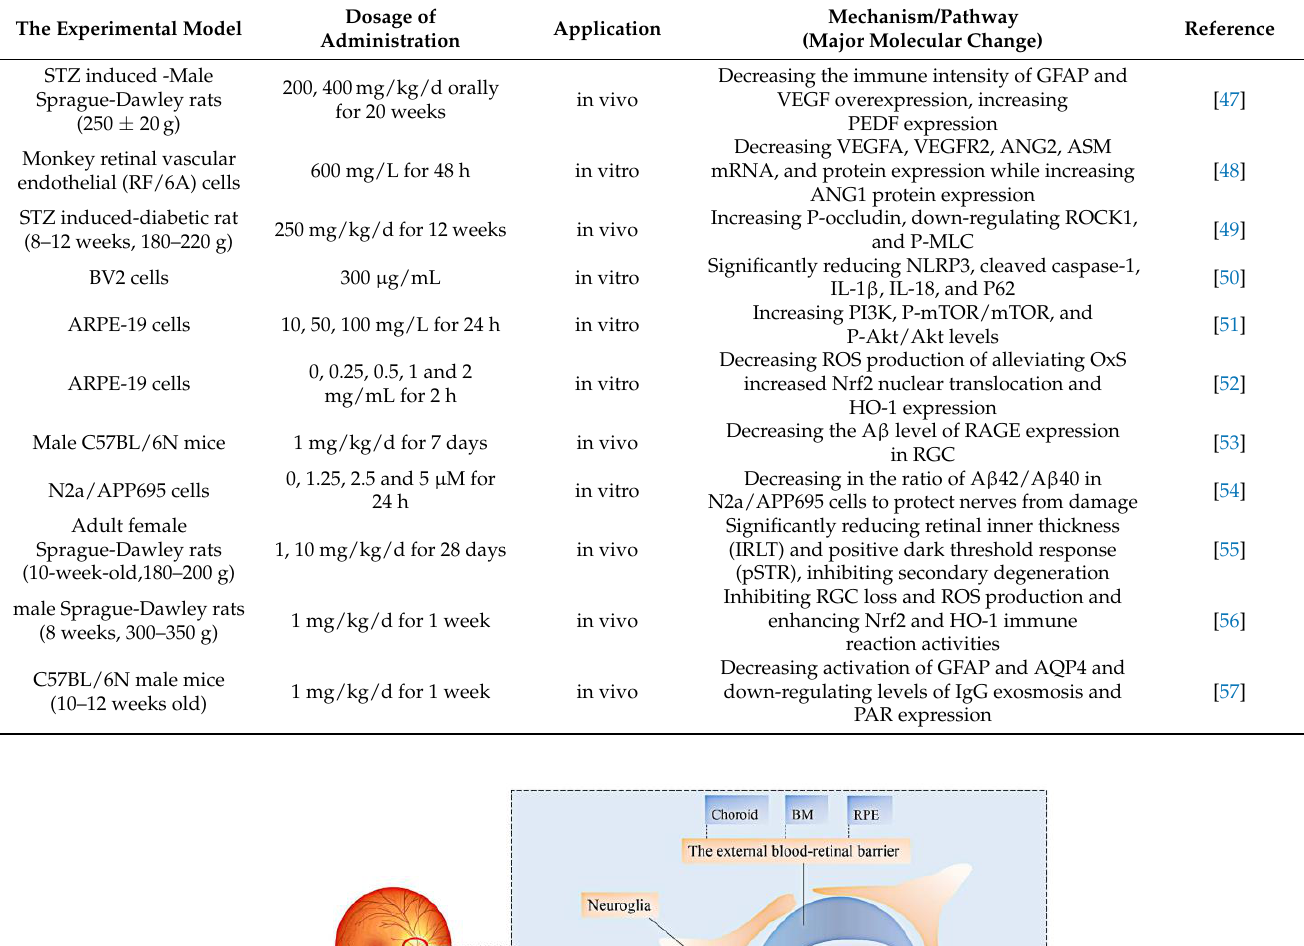
Table 1. Summary of protective effect of the LBP on vascular retinopathy in the experimental model.